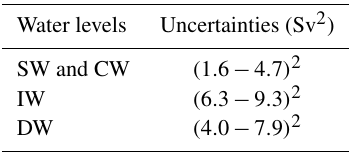
Table 3. A priori noise of equations corresponding to the SW, CW, IW and DW levels at which the different water masses are trans-